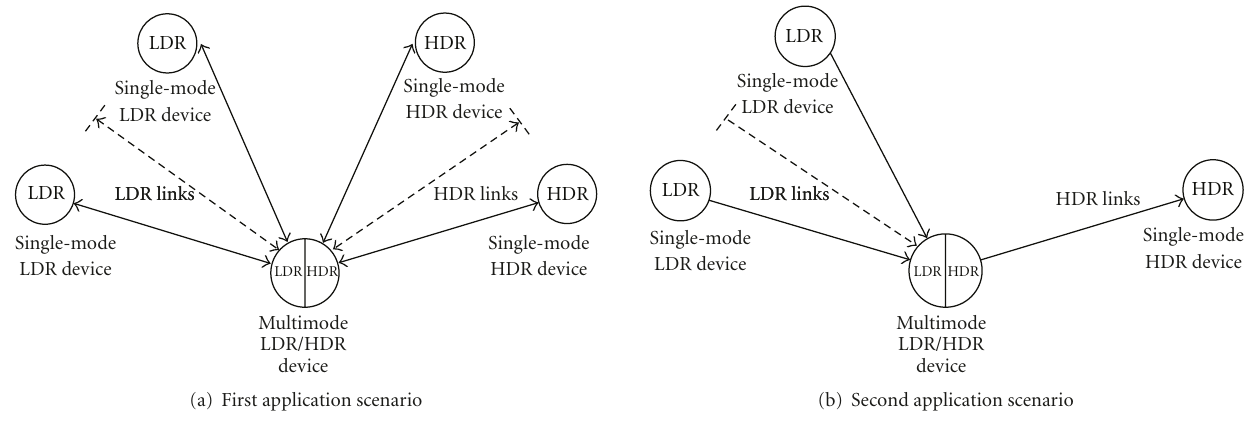
Figure 1: Examples of application scenarios for multimode LDR/HDR WPAN devices.